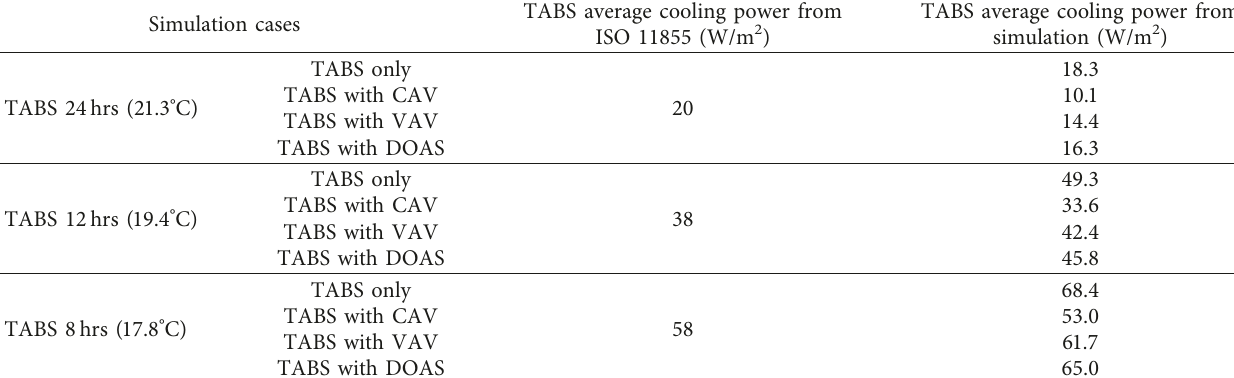
Table 2: Average cooling power comparison of standard and simulation.